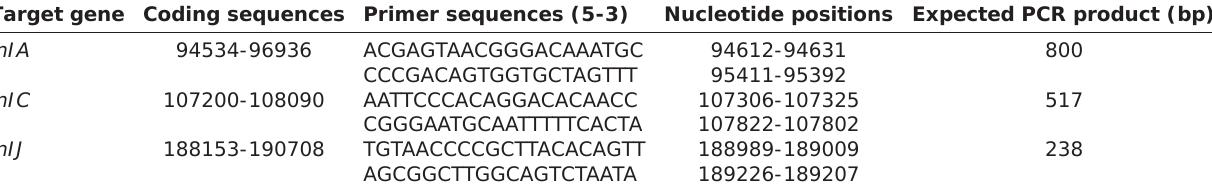
Table-1: Oligonucleotide sequences of the primers used in multiplex PCR assay for L. monocytogenes. Target gene Coding sequences Primer sequences (5-3) Nucleotide positions Expected PCR product (bp)